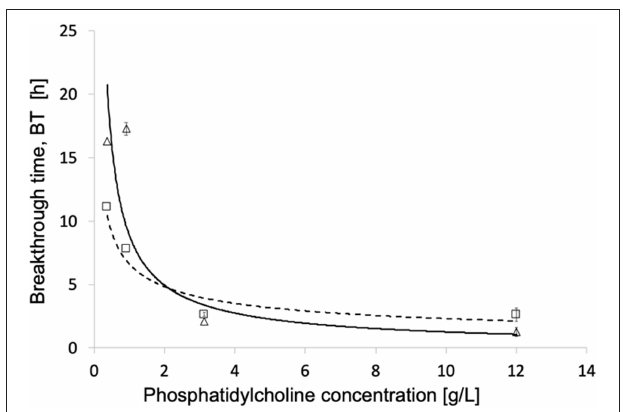
FIGURE 5 | Breakthrough time for different phosphatidylcholine concentrations of modules equipped with different membranes: ( 1 , - - - ) Type V; ( (cid:3) , ____ ) Type VI. Other operating conditions as in Materials and